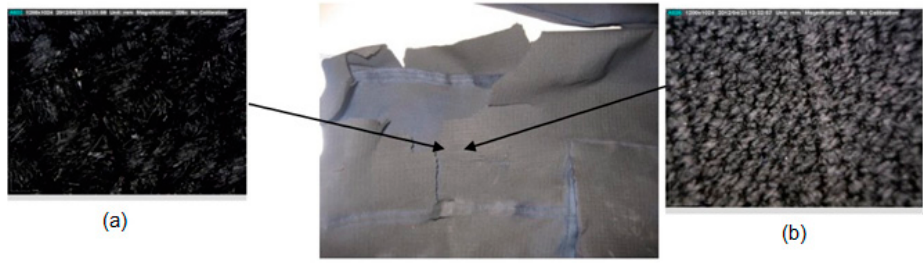
Figure 10. Damage to the left leg of the overalls (lower leg area) made with a Dino-Lite microscope in two different magnification: ( a ) 184×; ( b ) 60×.